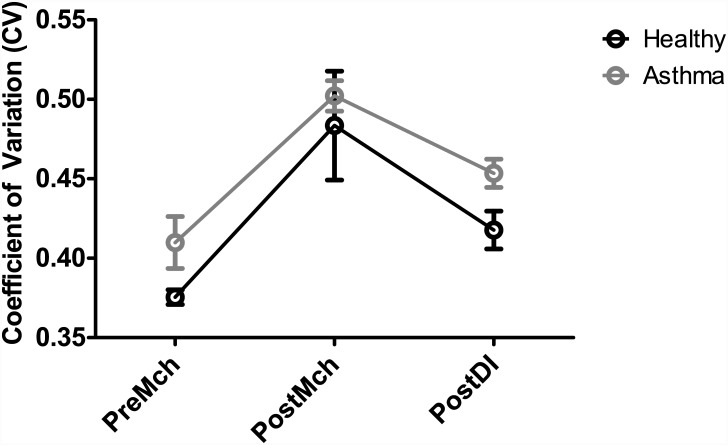
CV for PreMch, PostMch, and PostDI conditions with corresponding standard errors.Note across all three conditions, the mean CVs for the asthmatic subjects were consistently higher than the mean CVs for the healthy subjects, although not statistically significant. Refer to Tables 2 and 3 for statistical significance in comparisons between PreMch, PostMch, and PostDI.